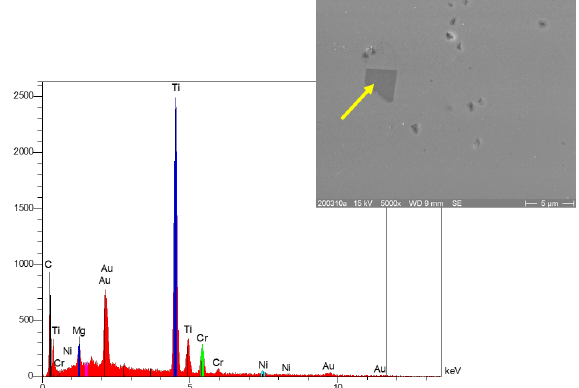
Figure 11. SEM micrograph of the Ti grain formed beneath the oxide scale of Cr-Ni after oxidation at 1200 °C in steam for 20 hours accompanied with EDS measurement of the marked point